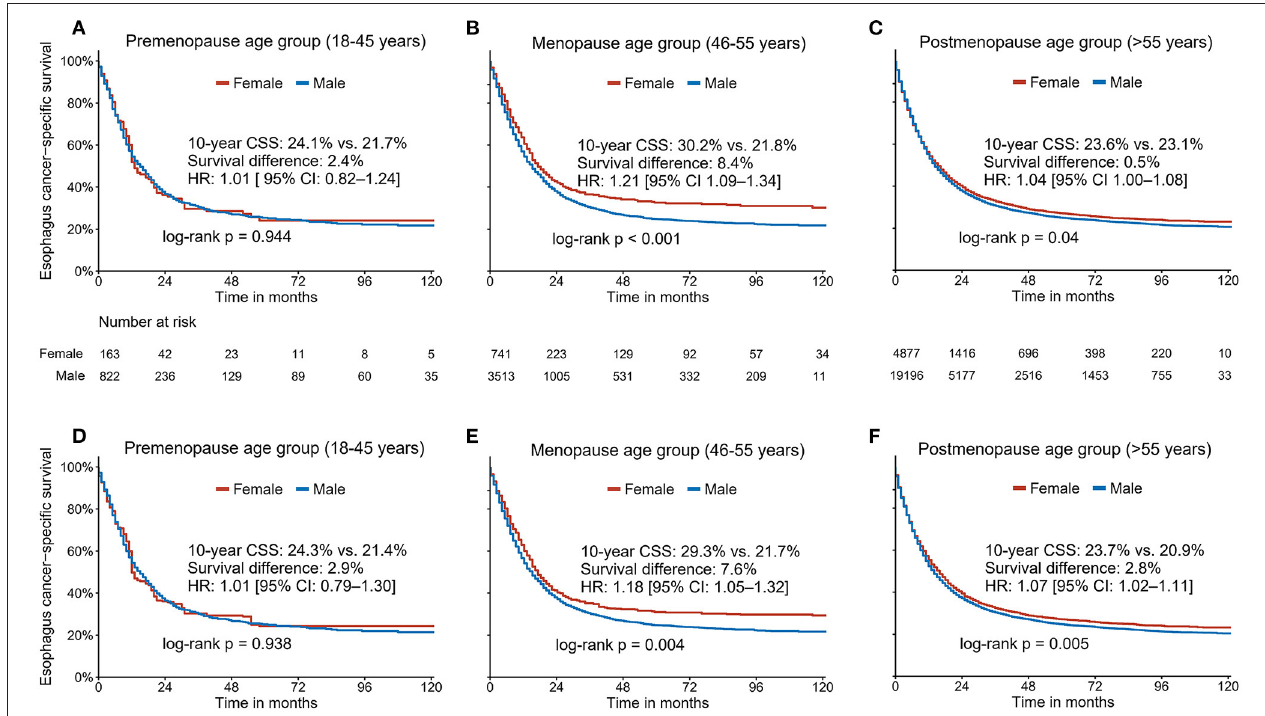
FIGURE 4 | The unadjusted (A–C) and Inverse Probability Weighting-adjusted (D–F) association between sex and cancer-specific survival in three different age groups (premenopausal age group: age ≤ 45 years; perimenopause age group: ages 46–55; and postmenopausal age group: age ≥ 56